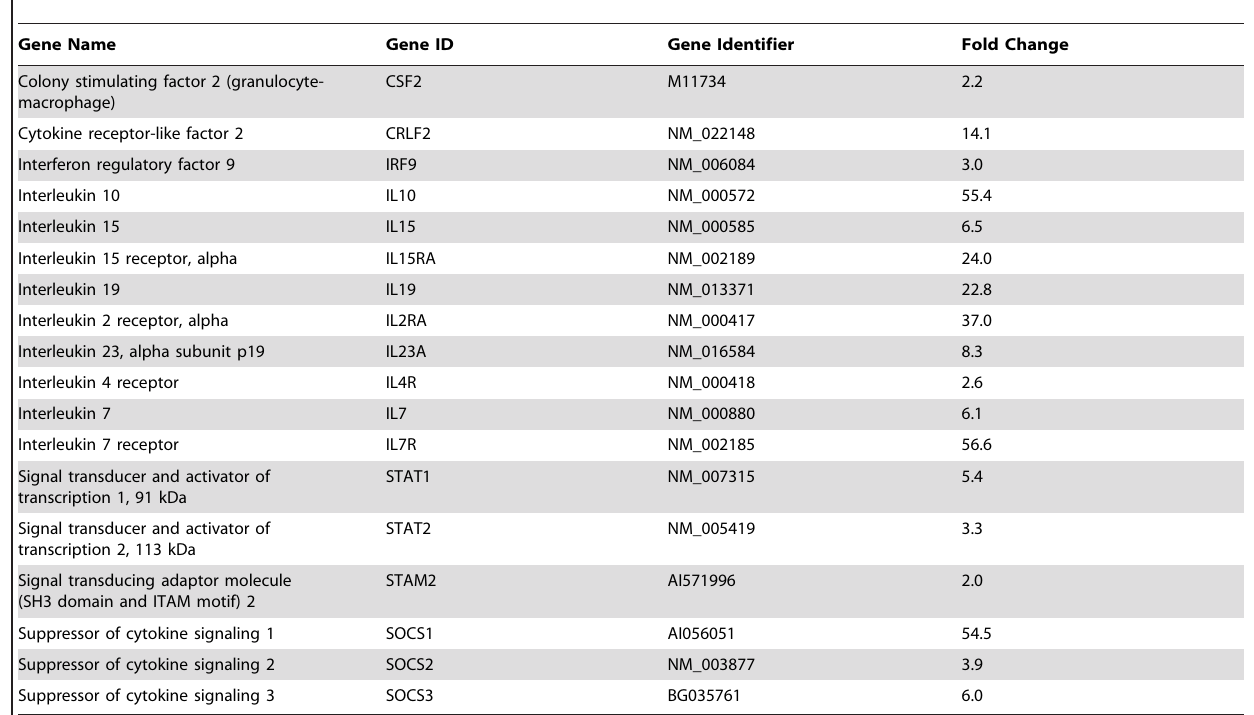
Table 4. Gene expression, all significantly up regulated, as detected by genome-wide microarrays for the JAK/STAT signaling pathway after 4 h of endotoxin stimulation in monocytes of the newly born (N